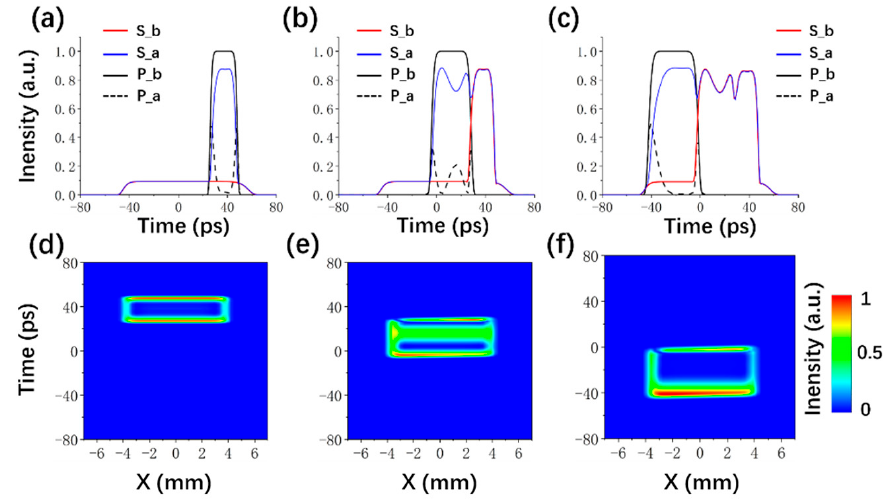
Figure 6. ( a – c ) The evolution of the signal and pumps in the temporal domain for triple-crystal scenario, ( d – f ) the temporal distributions of the residual pump along X axis for OPA1, OPA2 and OPA3, respectively.